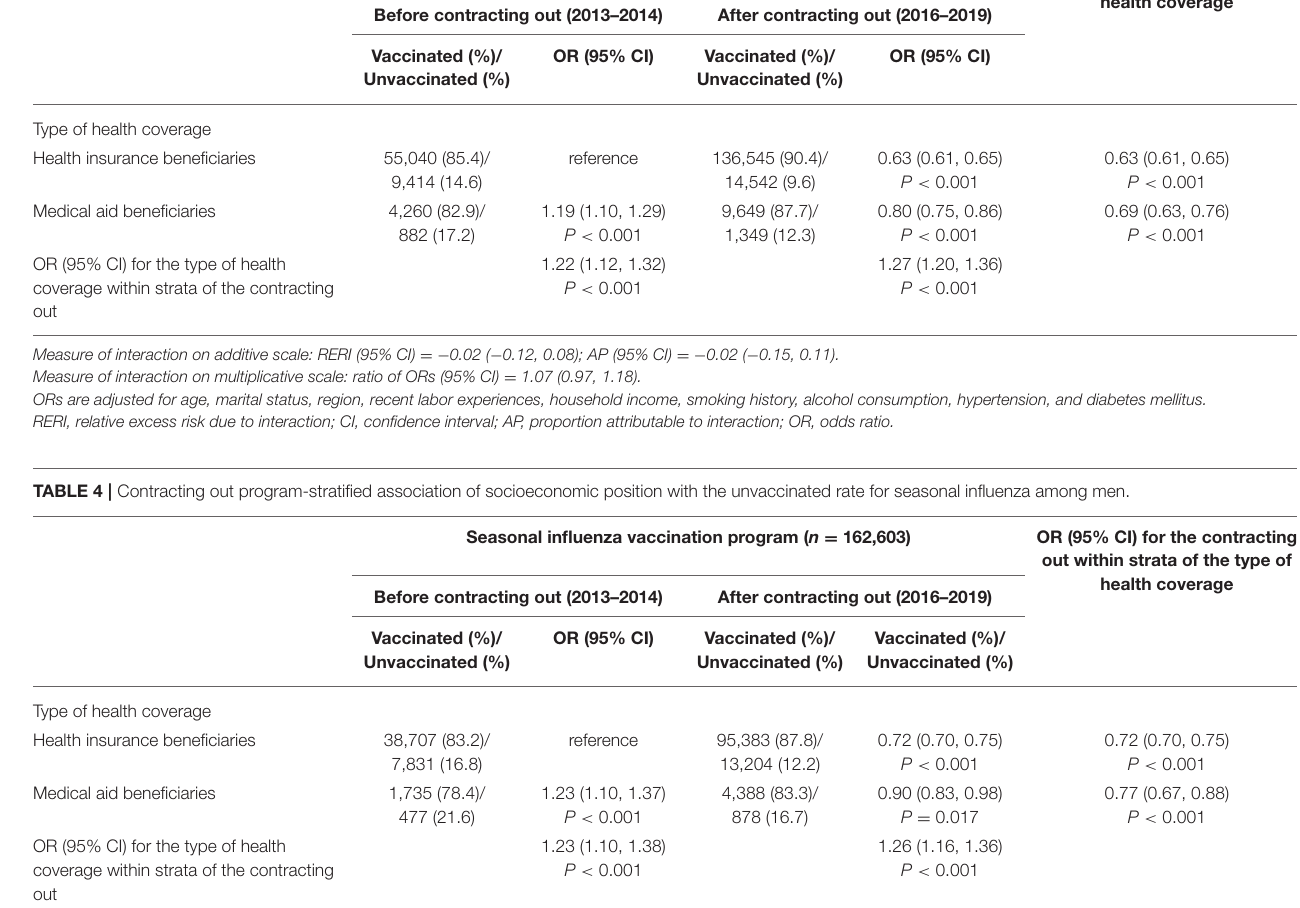
TABLE 3 | Contracting out program-stratified association of socioeconomic position with the unvaccinated rate for seasonal influenza among women. Seasonal influenza vaccination program ( n = 2,31,681) OR (95% CI) for the contracting out within strata of the type of